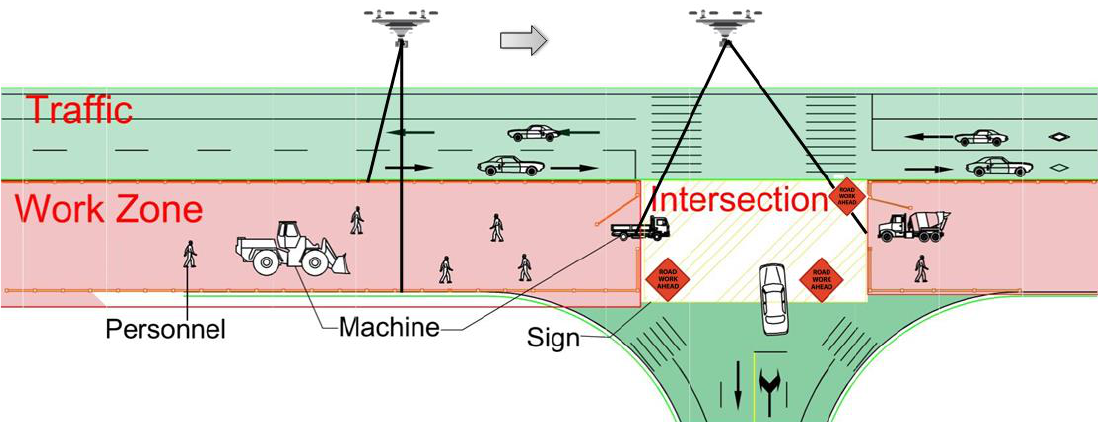
Figure 2. Partition of the road construction site.